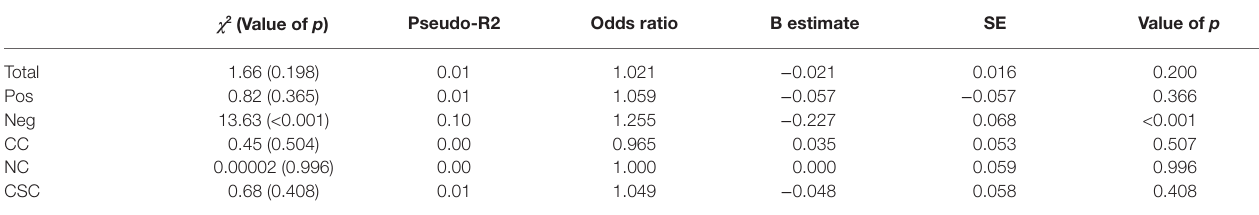
TABLE 7 | Associations between the MCQJ-30 score and state anxiety using logistic regression analysis. χ 2 (Value of p )